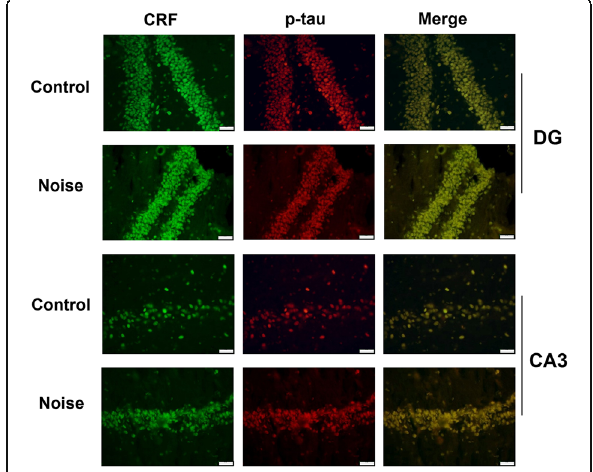
Fig. 4 Co-localization of CRF and p-tau (T205) in the rat hippocampus. CRF fluorescence (green), p-tau fluorescence (red), and merged images of CRF and p-tau (yellow) in the hippocampus. Representative images of the rat hippocampal DG region and CA3 region immediately after cessation of noise exposure. Scale bar = 20 μ